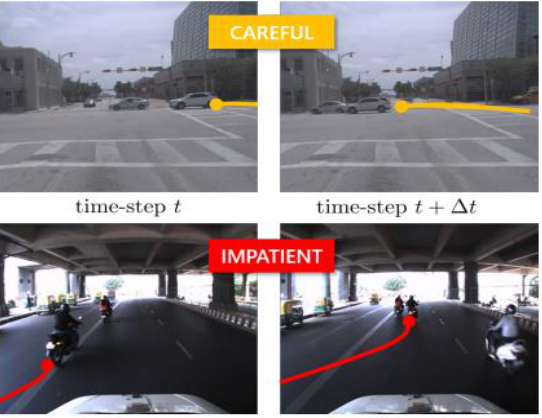
Figure 6. Trajectories generation produced in Ref. [41] for two different contexts. Through the traits shown by the road agent’s trajectory, their behaviors is then